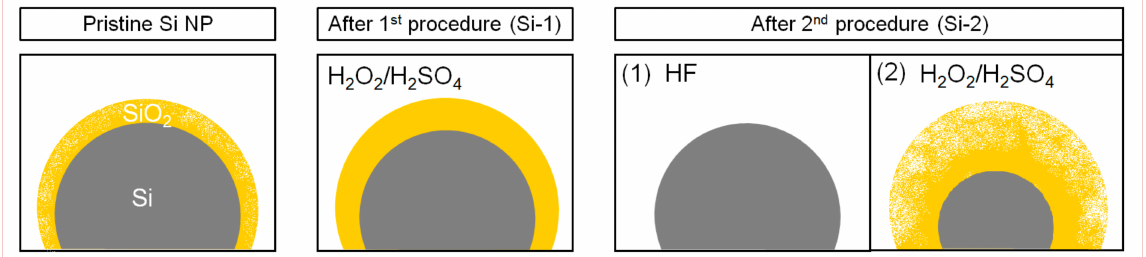
Figure 3. Schematic representation of the e ff ect of performed procedures to the Si-oxide